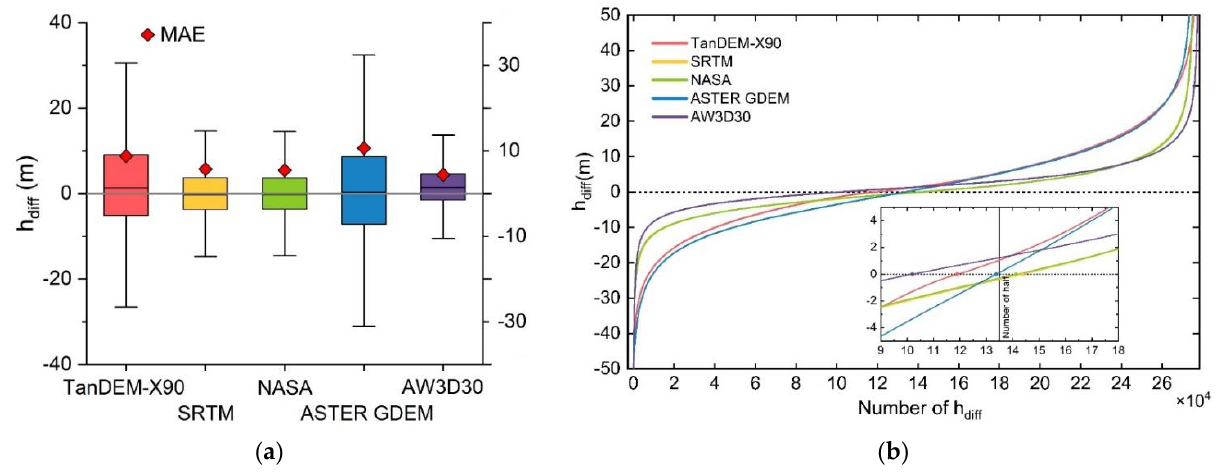
Figure 5. ( a ) Boxplot of five DEM products in the study area. ( b ) The error distributions of these five DEMs. five